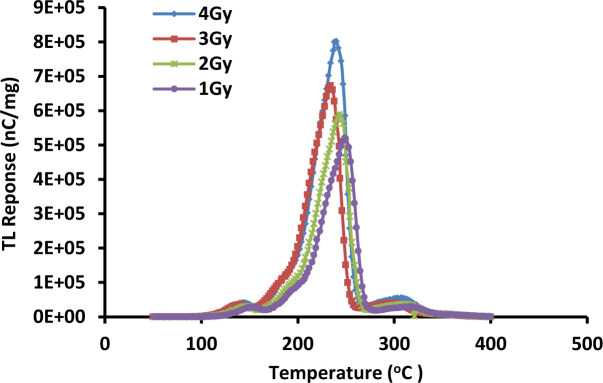
Typical TL glow curve for TLD-100 for delivered doses in the range 1–4 Gy at fixed energy and dose-rate of 6 MeV and 400 MU/min respectively, determining the effect of dose on the TL glow curve.